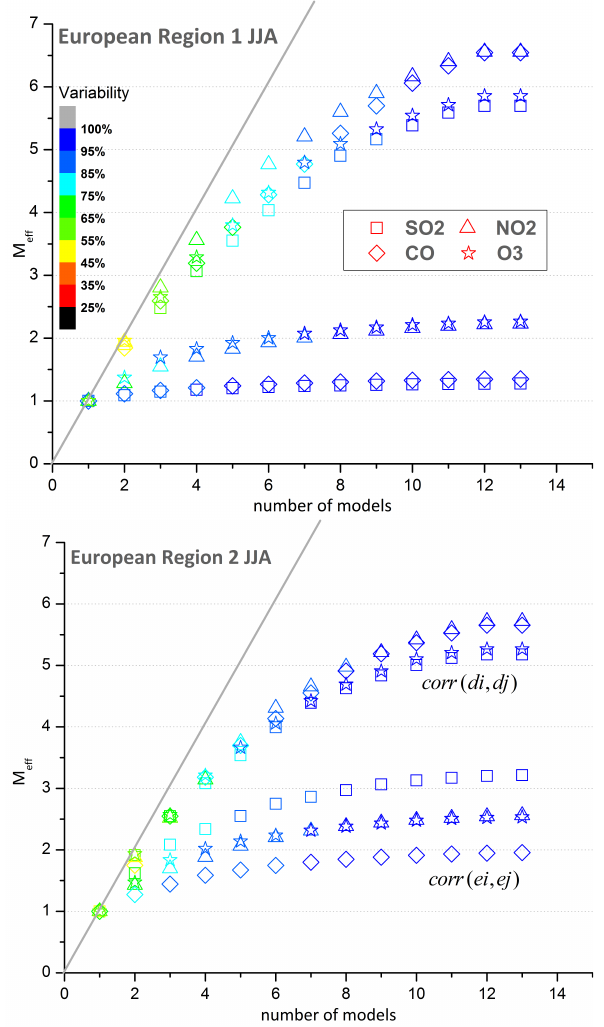
Fig. 4. M eff (Eq. 7) as function of the number of models for EU region 1 and region 2. The two sets of curves have been generated from the corr( d i ,d j ) (top curves) and the corr( e i ,e j ) (lower curves) matrixes. The cumulative variability is colour coded. In grey is the one-to-one